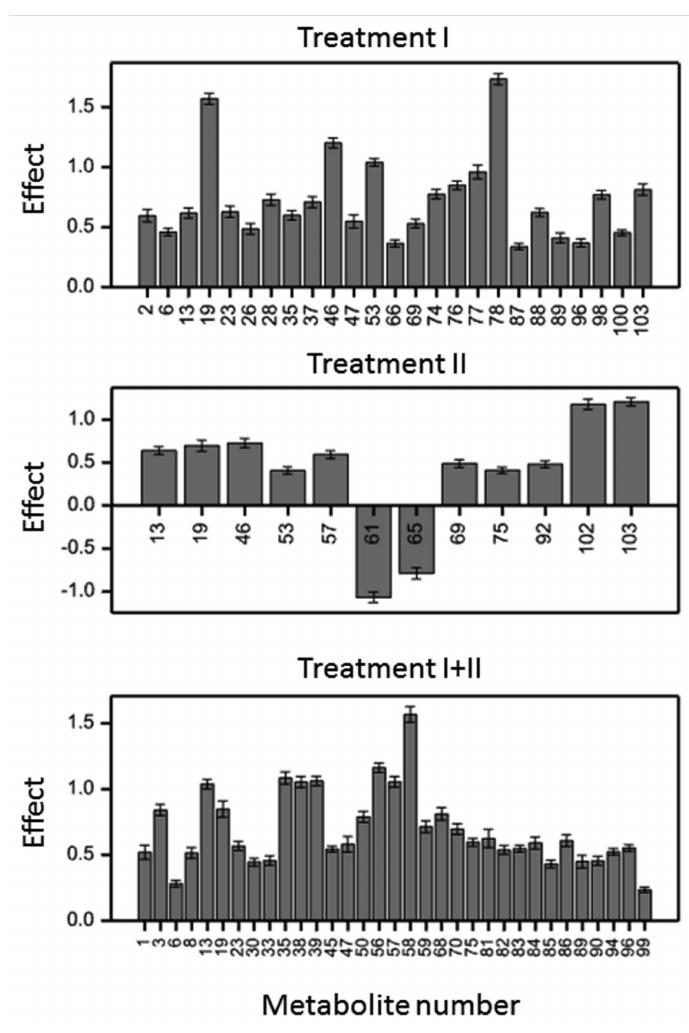
Figure 1. E ff ects of water deficiency for metabolites that reacted in a similar way in all varieties and at all time points, under treatments I, II and I +